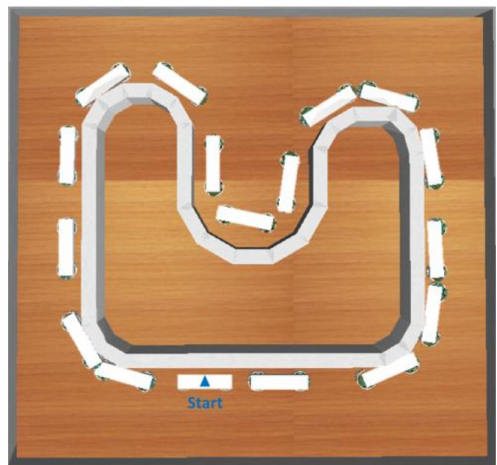
Figure 25. Moving path of the proposed method.